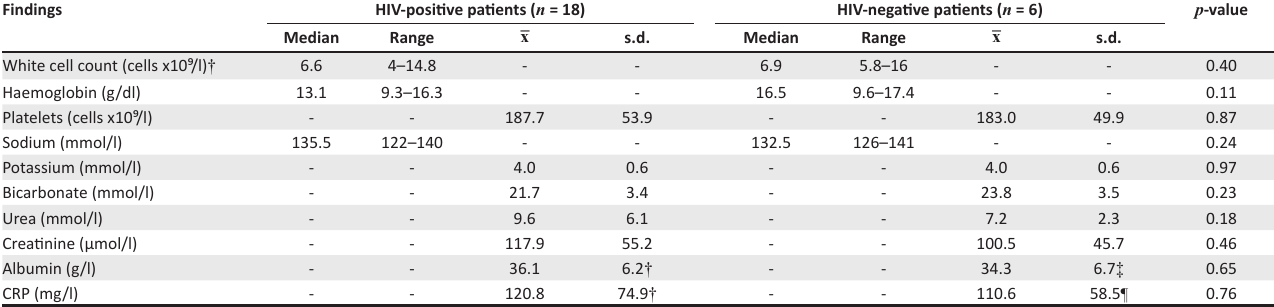
TABLE 3: Laboratory findings in 24 adult patients with measles: Comparison of HIV-positive and HIV-negative cases.